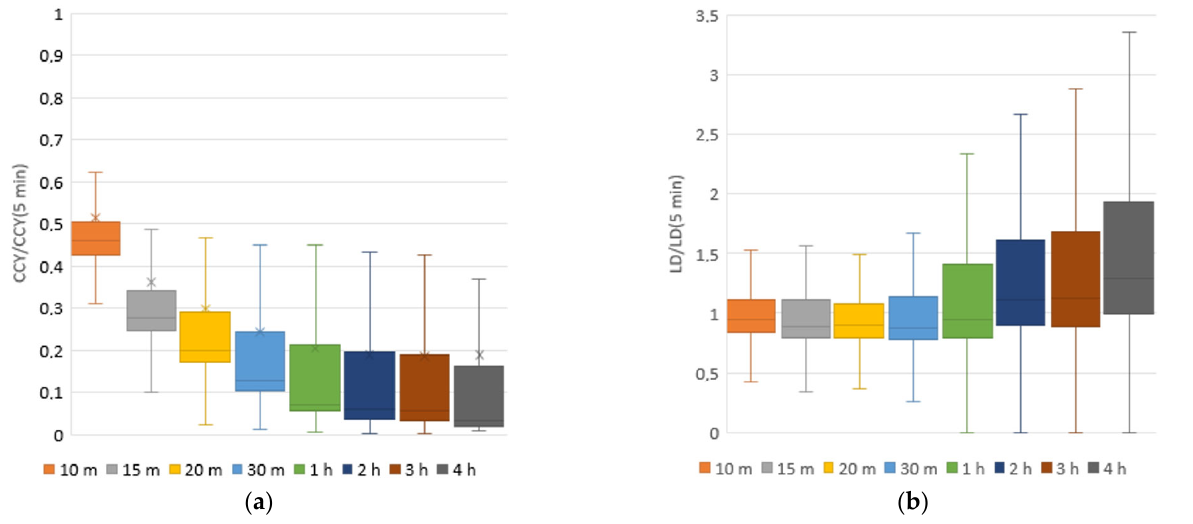
Figure 5. Diagrams of ( a ) CCY and ( b ) LD for station ID23005. Three ‐ month datasets.